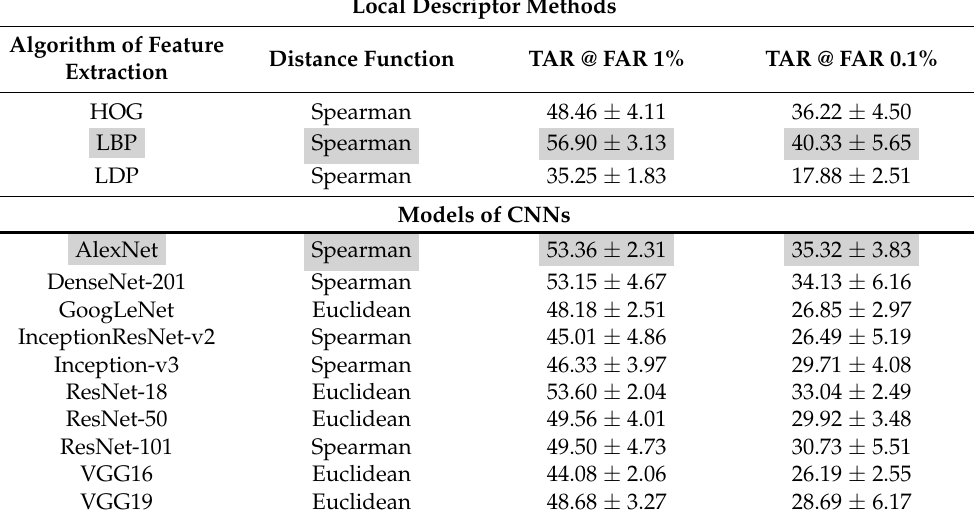
Table 3. TAR results for the local descriptor and CNN models with the decision function based on